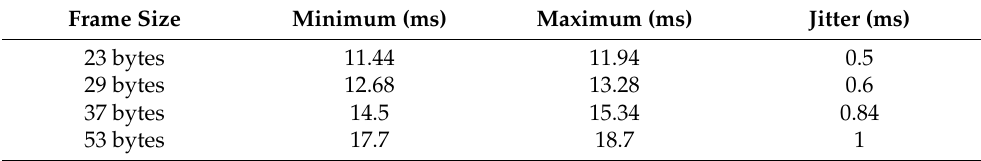
Table 5. Reception timestamps of Smart Measuring Nodes at the Coordinator Node (in